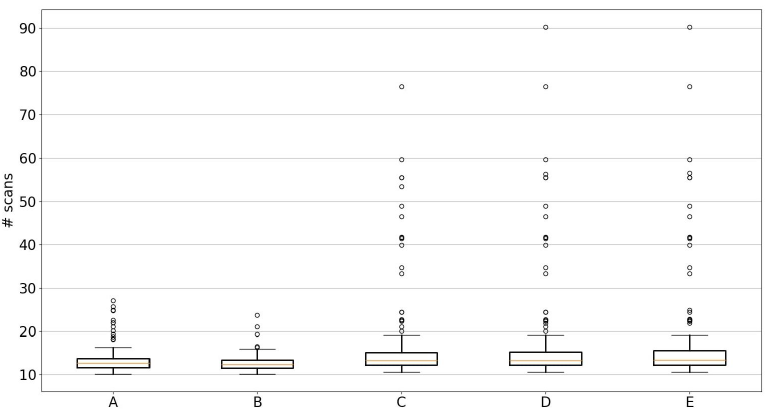
Figure 12. Localization performance. Metric A: the first time step when vehicle remains localized for the whole simulation without track loss. Metric B: the very first time step at which the vehicle satisfies localization criteria. Metric C: the first time step when the vehicle satisfies localization criteria and is within ± 5 m of the true vehicle position for 10 consecutive time steps. Metric D: Same as metric C but checks for 50 consecutive time steps. Metric E: Same as metric D but has stricter criteria of ± 2.5 m of the true